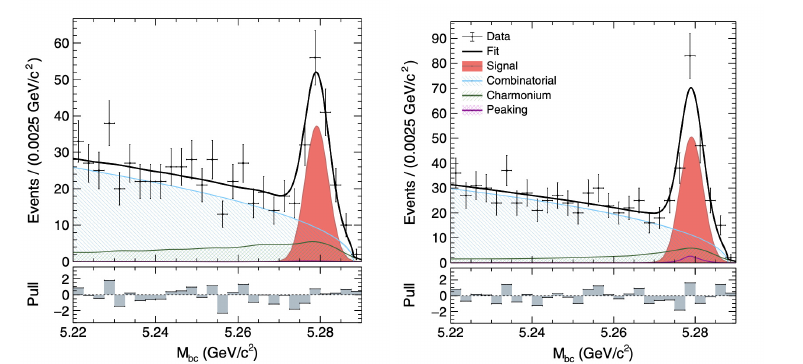
Figure 4. Fit result of B → K ∗ `` in terms of M bc for the electron (left) and muon (right) modes with q 2 > 0 . 045 GeV 2 / c 4 . Combinatorial (dashed blue), signal (red filled), charmonium (dashed green), peaking (purple dotted), and total (solid) fit distributions are superimposed on data (points with error bars).